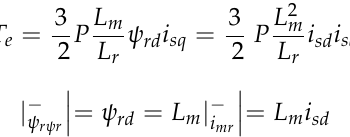
Figure 3. Schematic of the Grid Side Converter control.